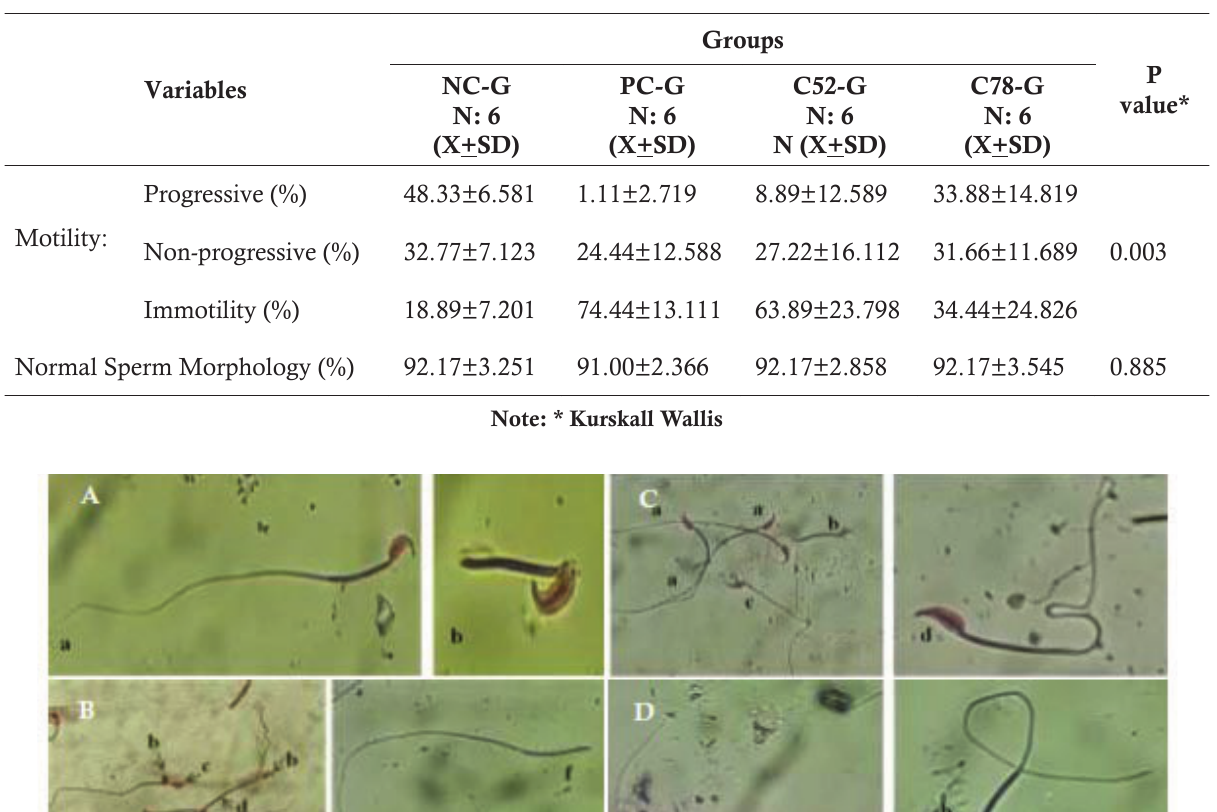
Table 1. Description of Mean Value±SD Percentage of Normal Spermatozoa Motility and Morphology